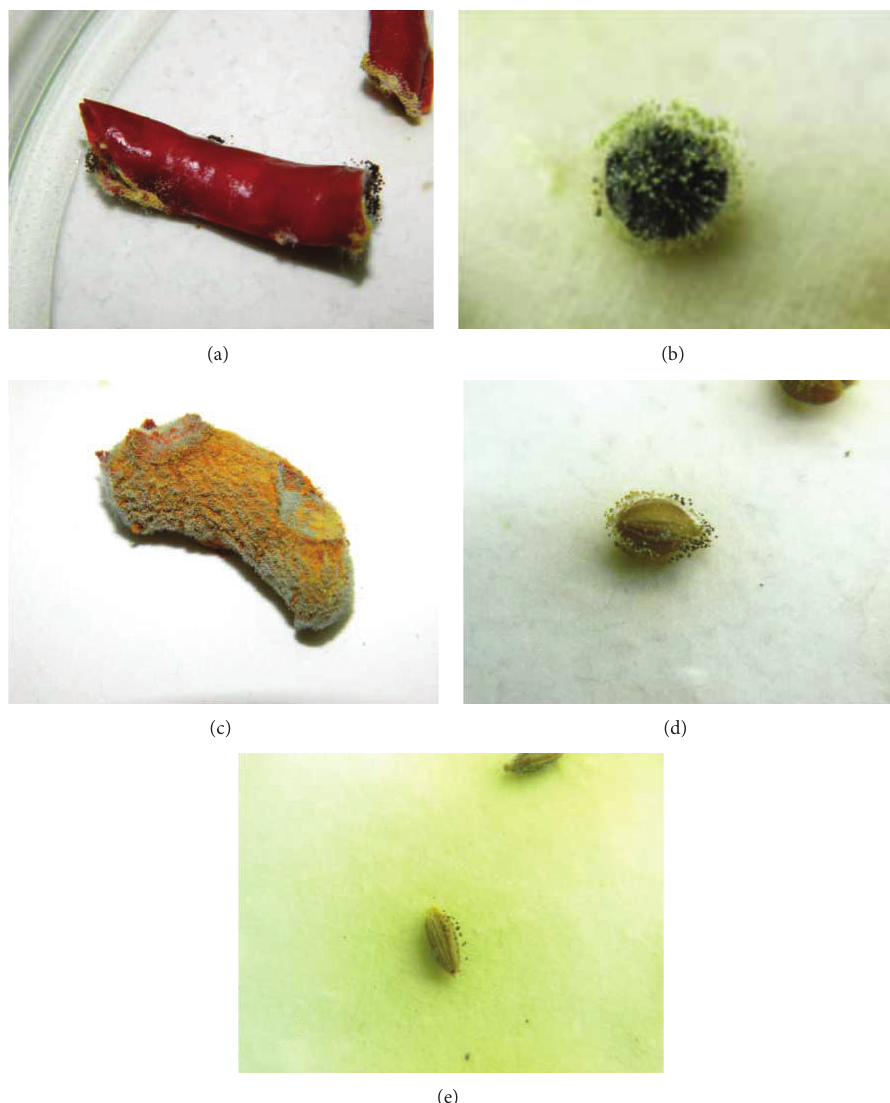
Figure 2: Fungal association of toxigenic fungi in different spices. (a) Red chilli associated with A. flavus and A. niger , (b) A. flavus , A. parasiticus , A. niger , and the other fungal contamination in black pepper, (c) fungal contamination in turmeric, (d) coriander associatedwith different fungi, and (e) association of A. flavus and A. niger in cumin.